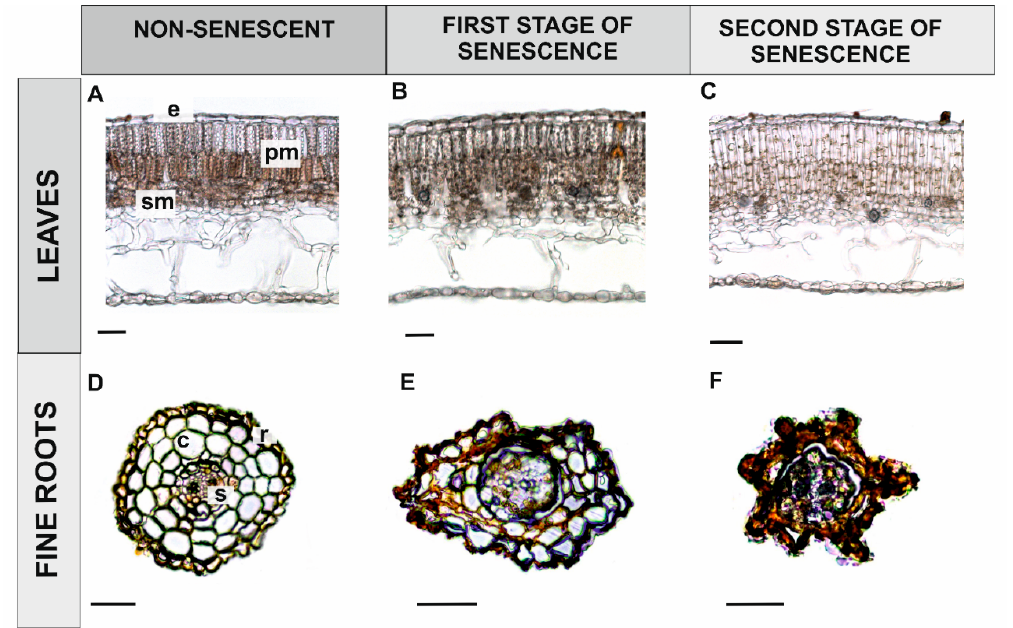
Figure 6. Localization of hydrogen peroxide (orange polymer) in senescing leaves and fine roots of black cottonwood ( Populus trichocarpa ). Control leaf ( A ), first stage of leaf senescence ( B ), second stage of leaf senescence ( C ), control fine root ( D ), first stage of fine root senescence ( E ), second stage of